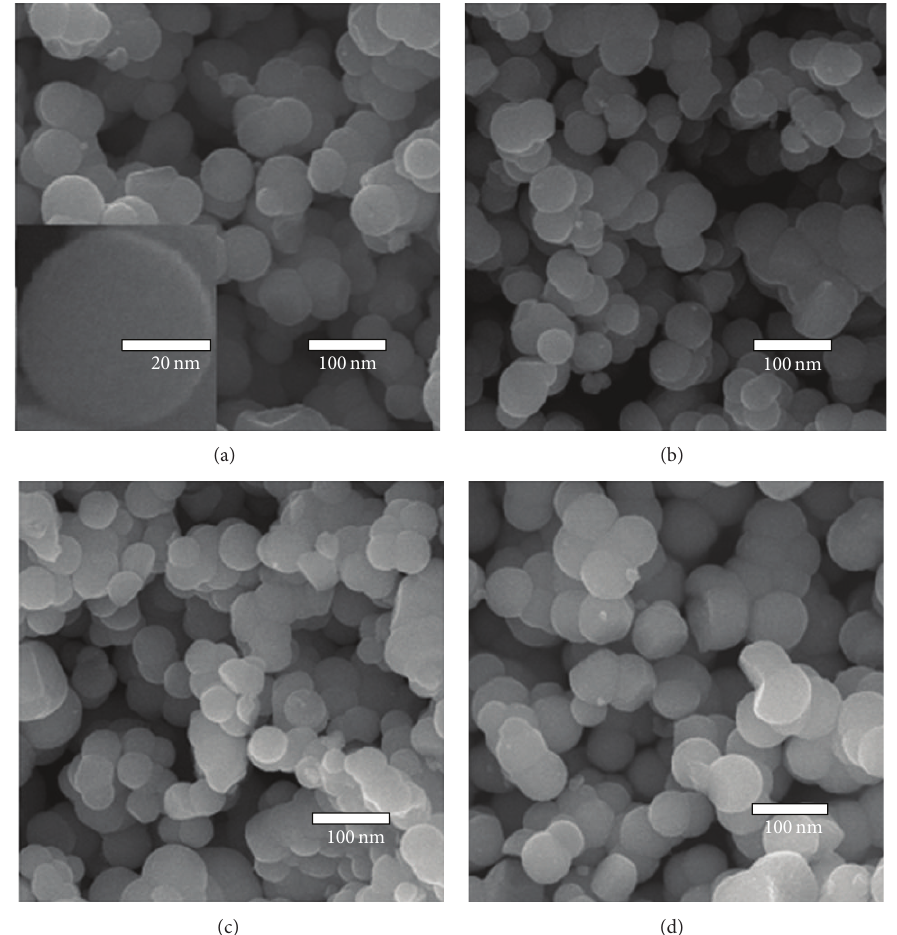
Figure 3: FESEM images of (a) pure, (b) Pt-, (c) Fe-, and (d) Zn-doped SnO 2 nanospheres.